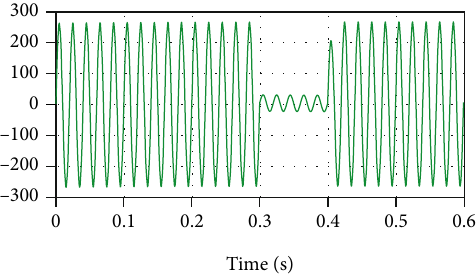
Figure 4: A sag in the estimated signal of grid voltage ̂ x